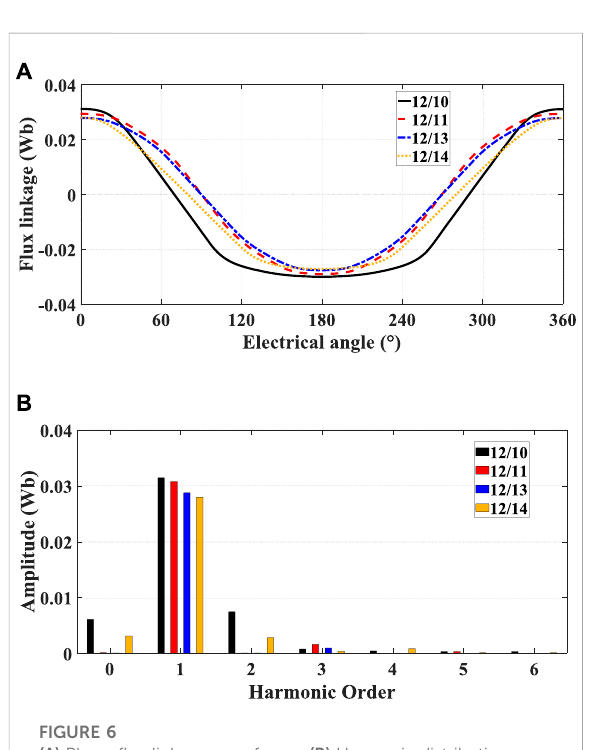
FIGURE 6 (A) Phase fl ux linkage waveforms. (B) Harmonic distribution.